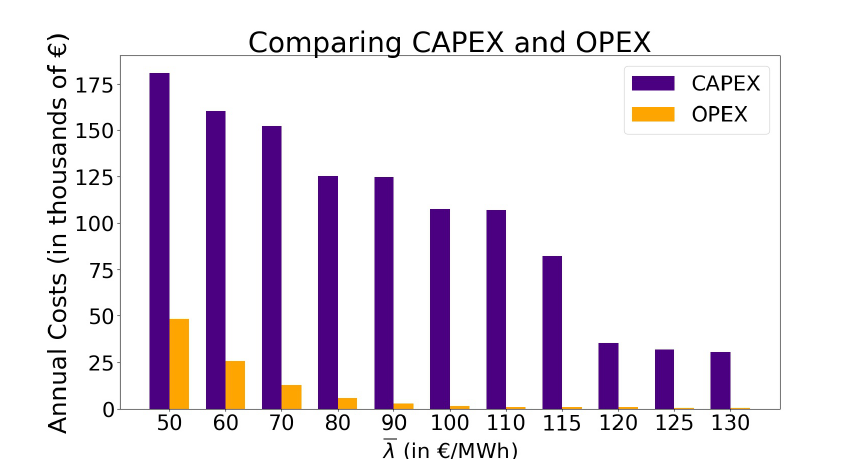
Figure 7. Computing CAPEX and OPEX under different contractual arrangements.